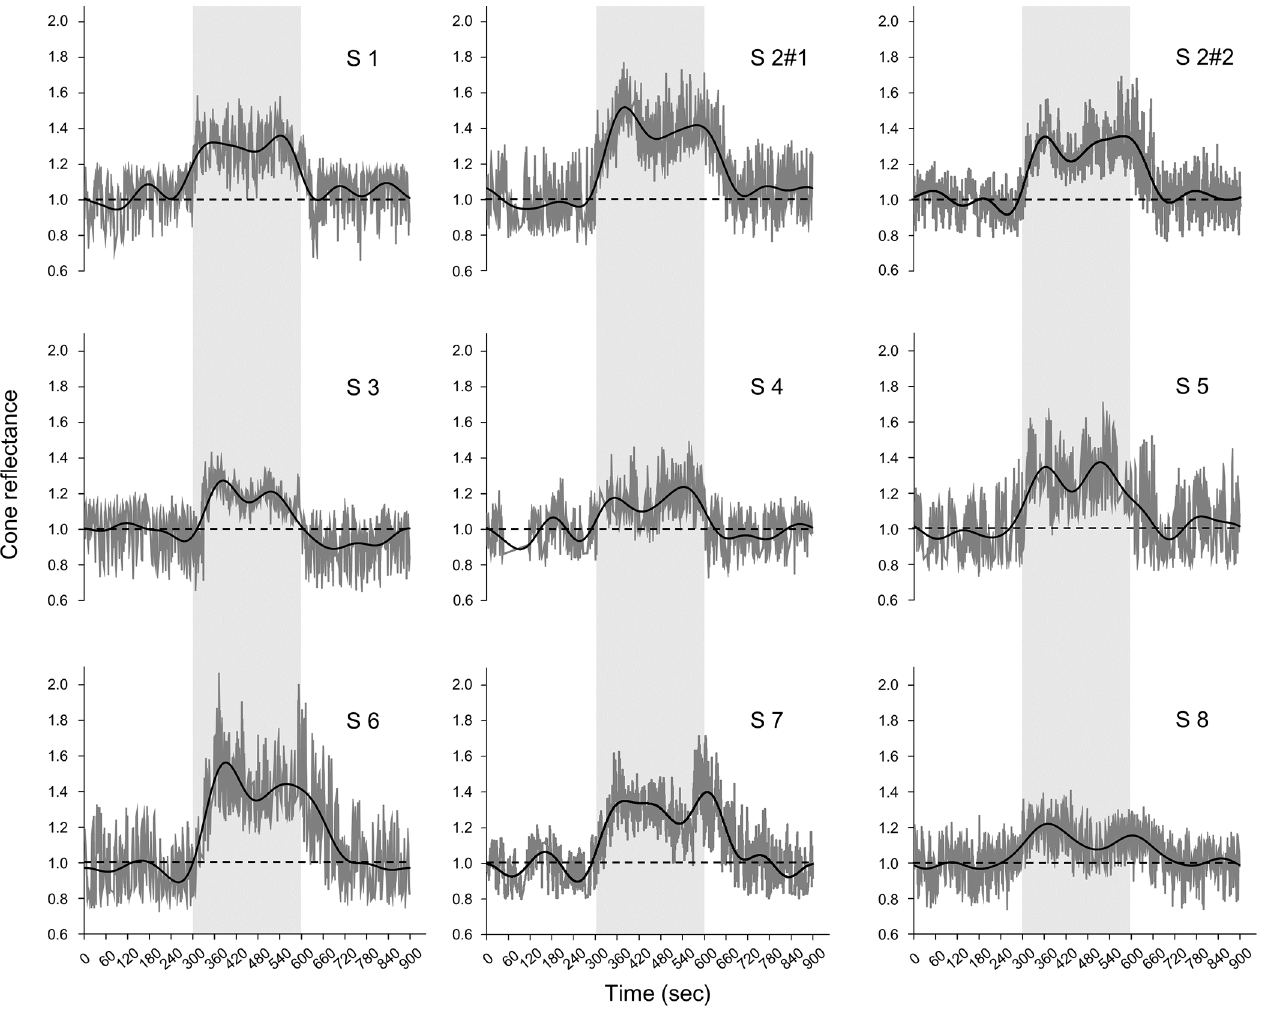
Fig 3. Reflectance changes at 1° temporal from the fovea. The dark gray lines indicate the reflectance changes at 1° temporal from the fovea. The black line shows the low-pass filtered data at 0.008-Hz. The dotted line indicates the baseline. The light gray zone indicates the period of light stimulation. Cone reflectances increased during light stimulation and had two peaks in all subjects. Subject 2 underwent the repeatability experiments (S2 #1 and S2